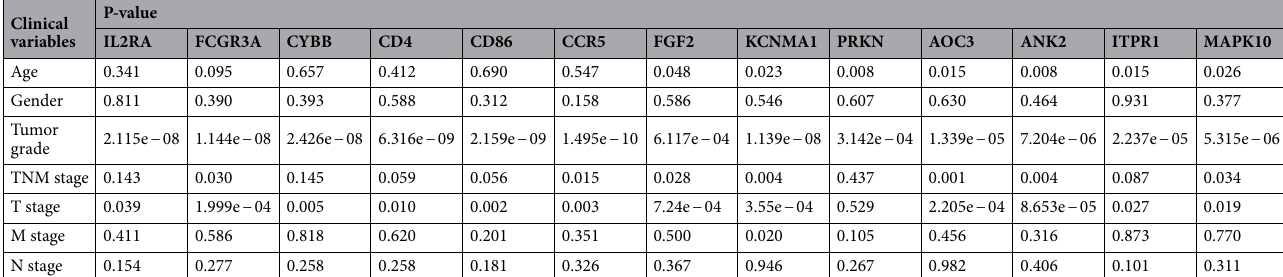
Table 2. Correction between 13 hub progression-associated OS genes expression and clinicopathological characteristics of